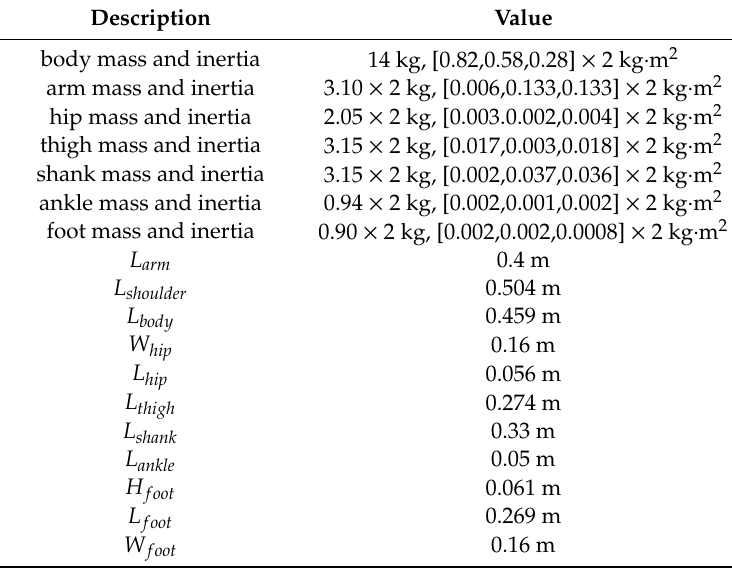
Table 1. Model parameters in simulation.